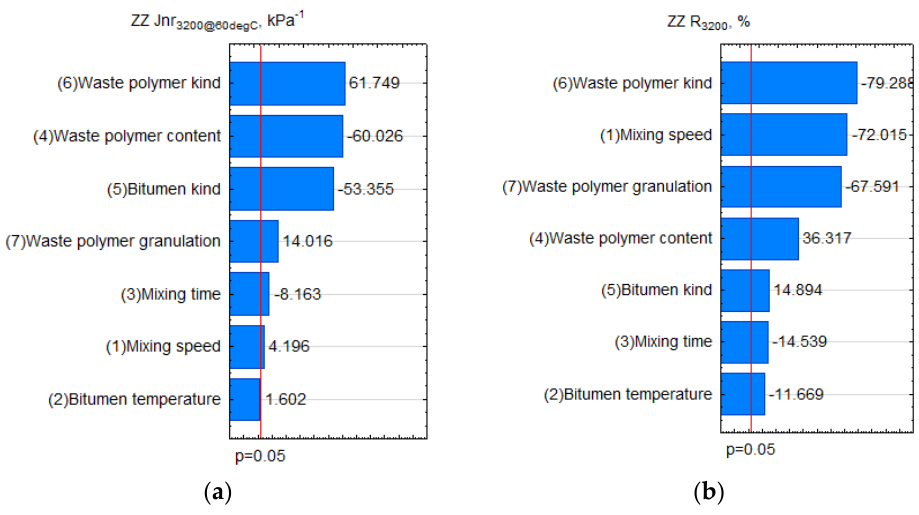
Figure 11. Pareto plot of standardised effects: ( a ) J nr3200 , ( b ) R 3200